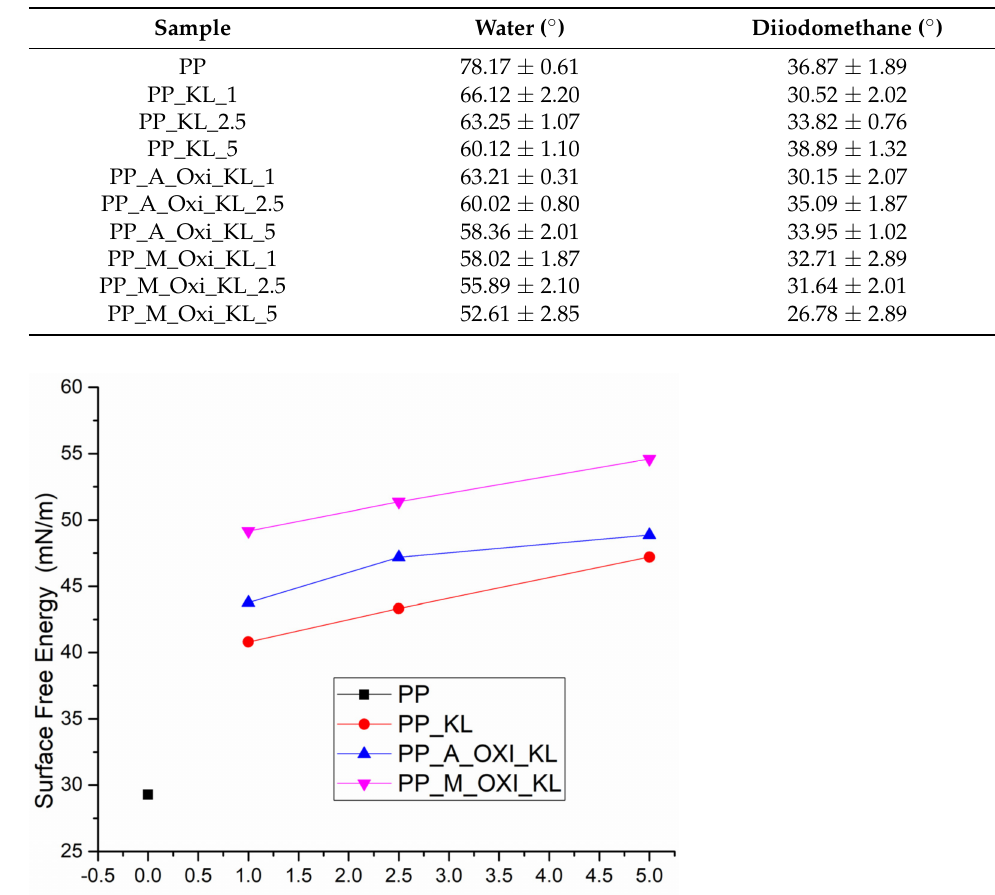
Table 4. Contact angles for water and diiodomethane on PP and PP-lignin films.